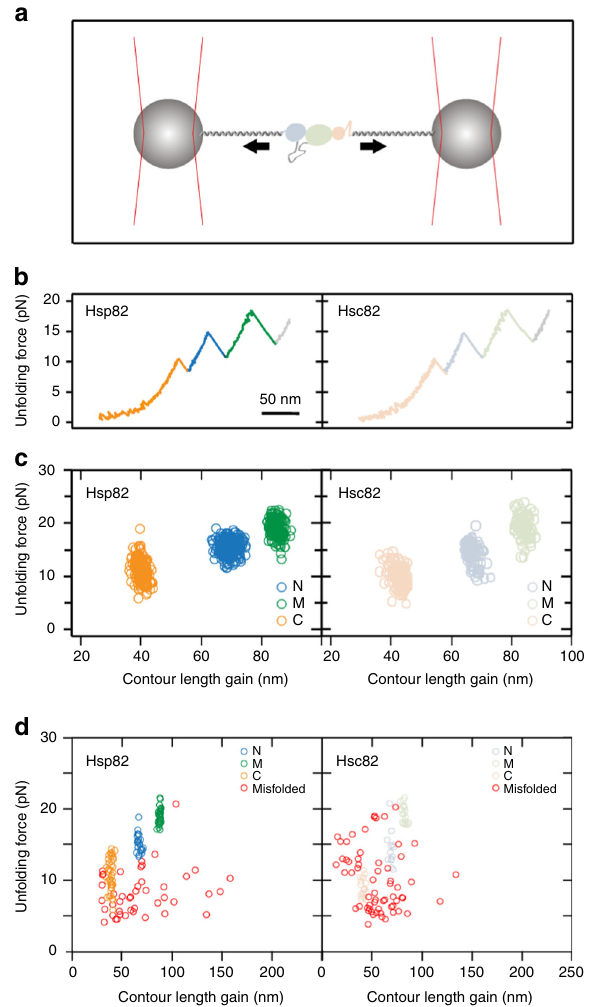
Fig. 2 Unfolding of Hsp82 and Hsc82. a Schematic depicting how force is applied across the monomer of Hsc82 or Hsp82 using optical trapping (see Methods for details). b Example unfolding traces of Hsp82 (left) and Hsc82 (right) pulled at a constant velocity of 500nm/s. The traces are colored according to domain. In both these example traces, the CTD is seen to unfold fi rst (shown in orange), followed by the NTD (blue) and fi nally, the middle domain (green). c Performing repeated force-extension cycles and recording the unfolding forces and contour length gains for each domain results in the scatter plots shown here. The average unfolding forces and contour length gains for Hsp82 and Hsc82 are the same within error (see Table 1). d Repeated force-extension cycles at 500nm/s with no waiting time at zero force result in large numbers of force-extension traces that do not show the native unfolding pattern. This occurs as a result of inter- and intra-domain misfolds in the monomers of Hsc82 and Hsp82, which is why misfolds with contour length gains longer than those of natively folded domains are common. Here, native mechanical signatures of individual domains are colored according to the domain (blue for the NTD, green for the middle domain, orange for the CTD), and events which did not match the native unfolding signatures for any domains are shown in red. Hsp82 data (left-hand side) is from 38 force-extension cycles for a single molecule, and Hsp82 data (right-hand side) is from 55 force-extension cycles for a single